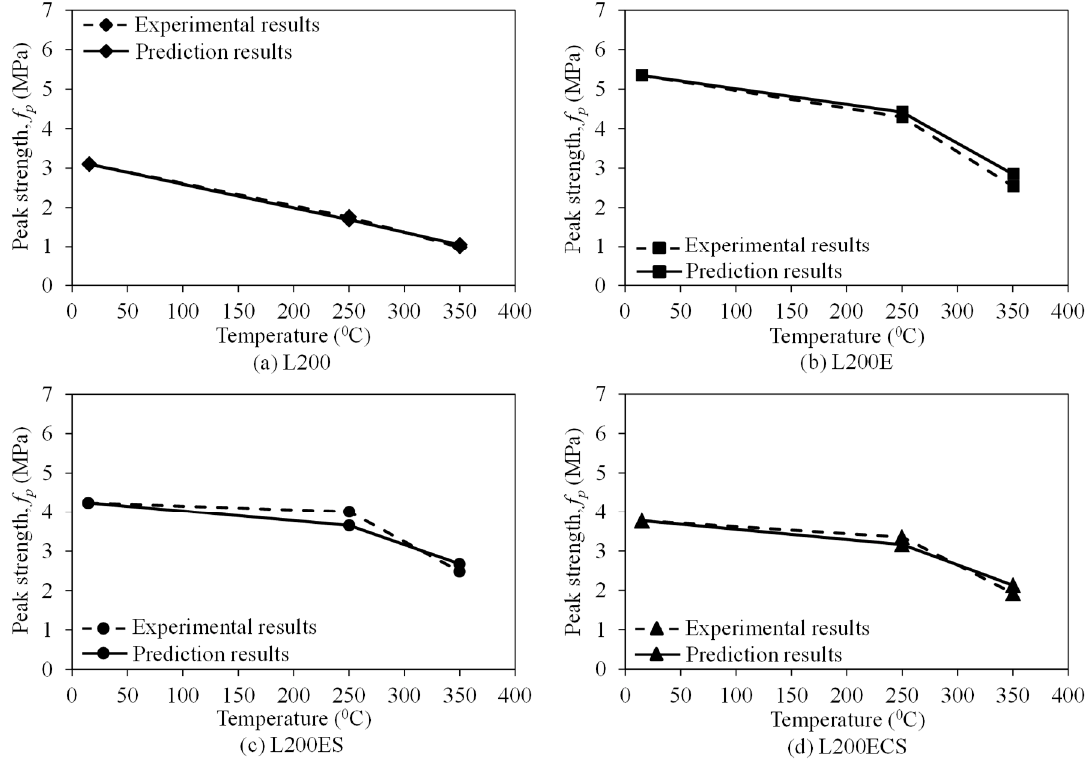
Figure 18. Predicted peak strengths of the TRM specimens according to temperature.